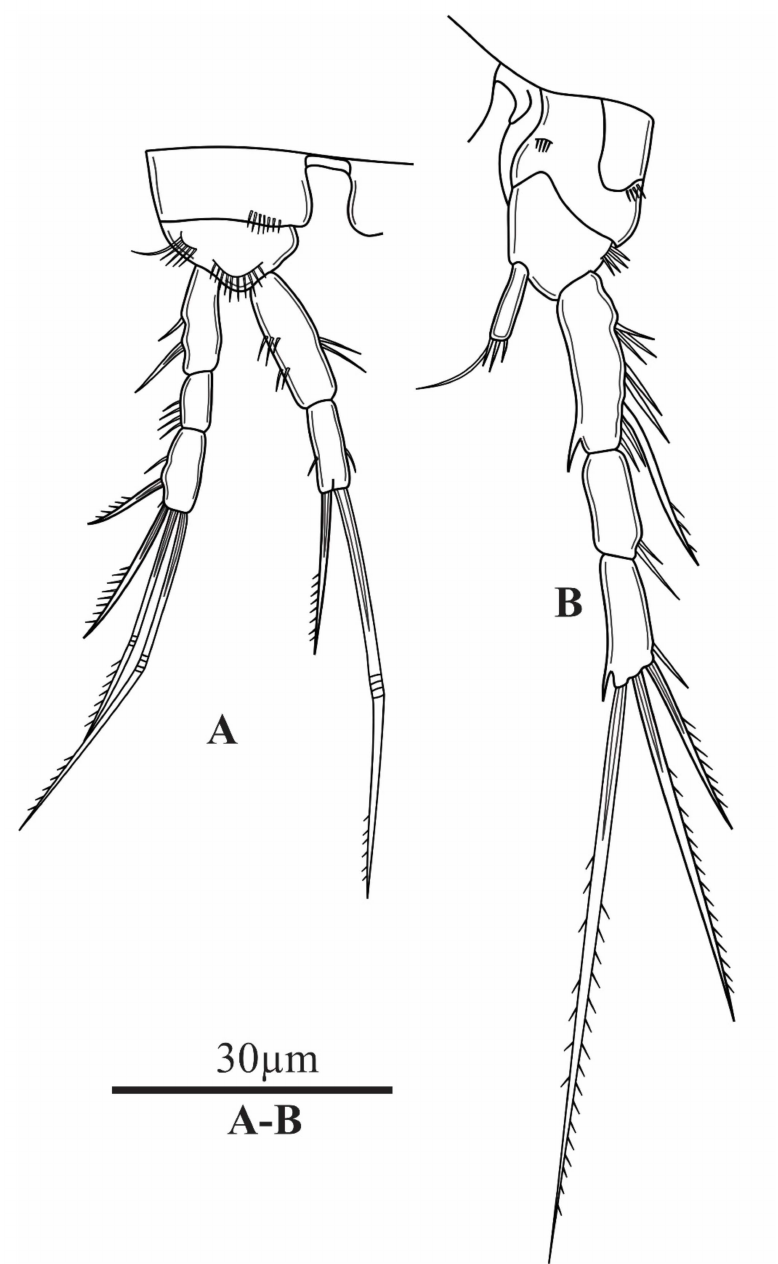
Figure 12. Parastenocaris vugiaensis sp. nov. female. ( A ), P1; ( B ),